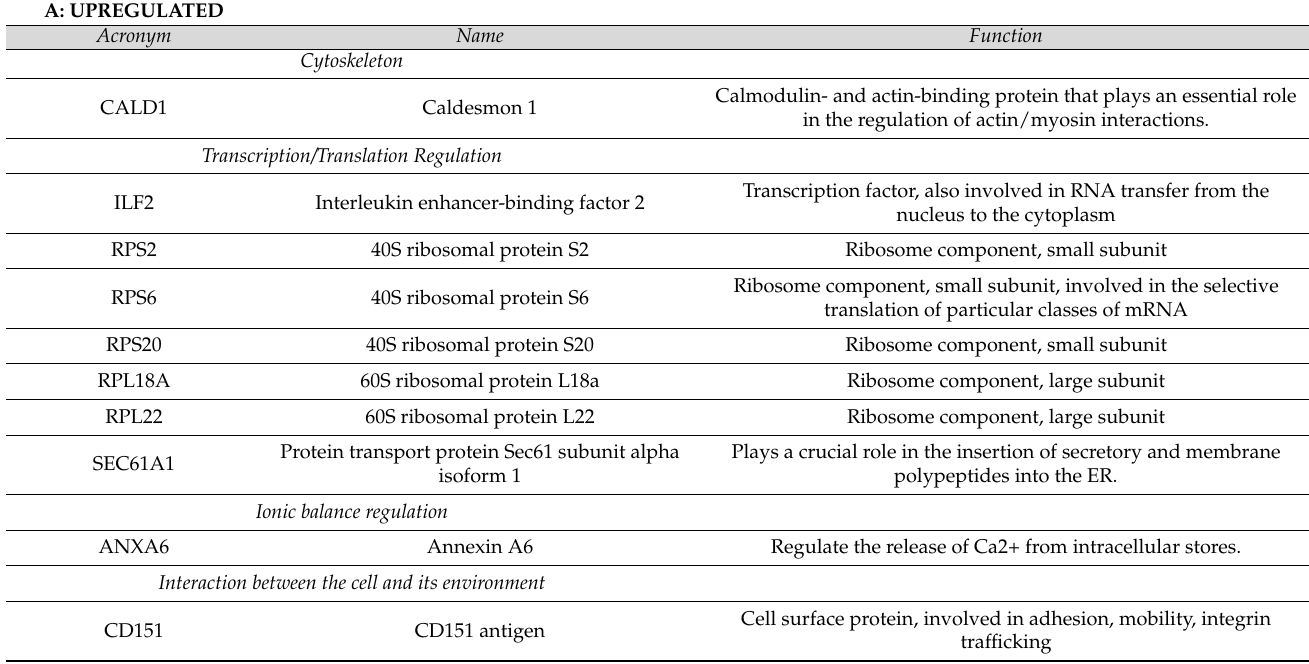
Table 2. Proteins which expression was altered between HO and